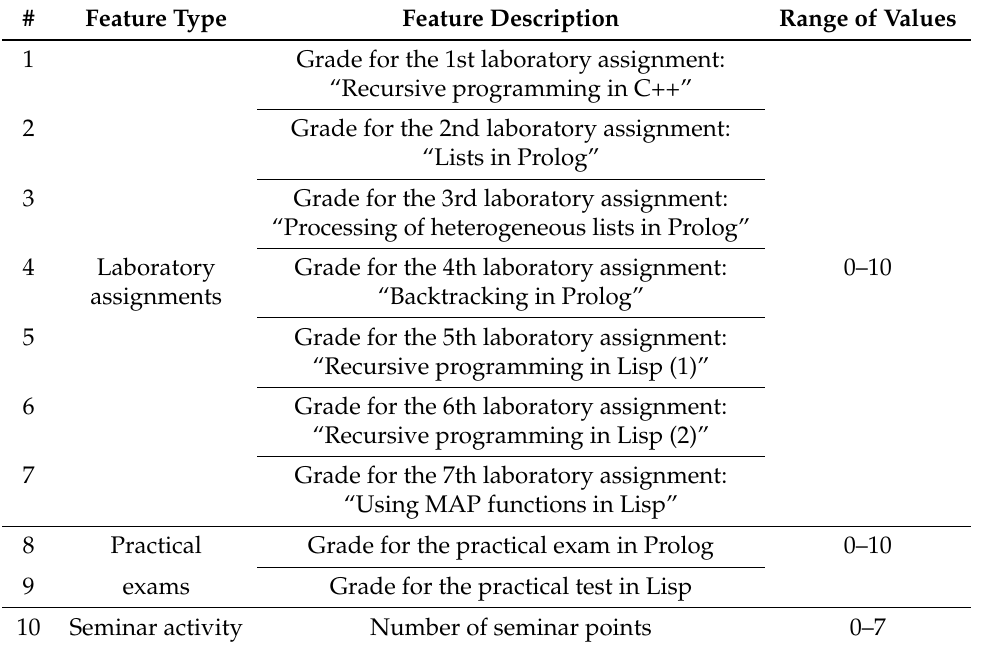
Table 1. Feature descriptions for the 2019–2020 academic year.